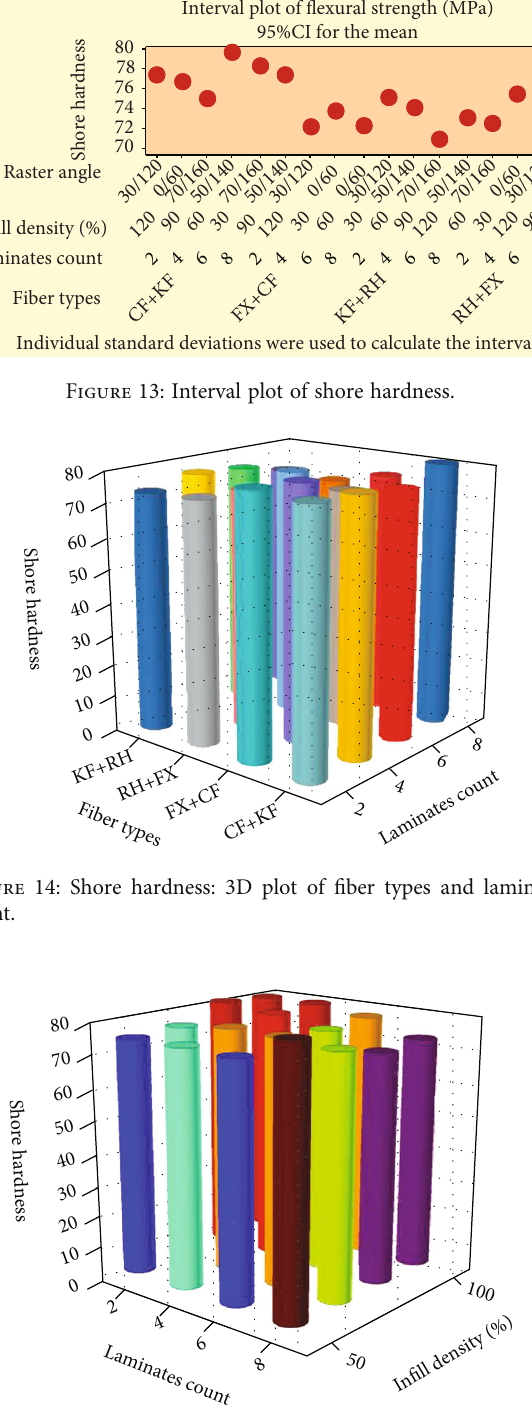
Figure 15: Shore hardness: 3D plot of laminate count and in fi ll density.